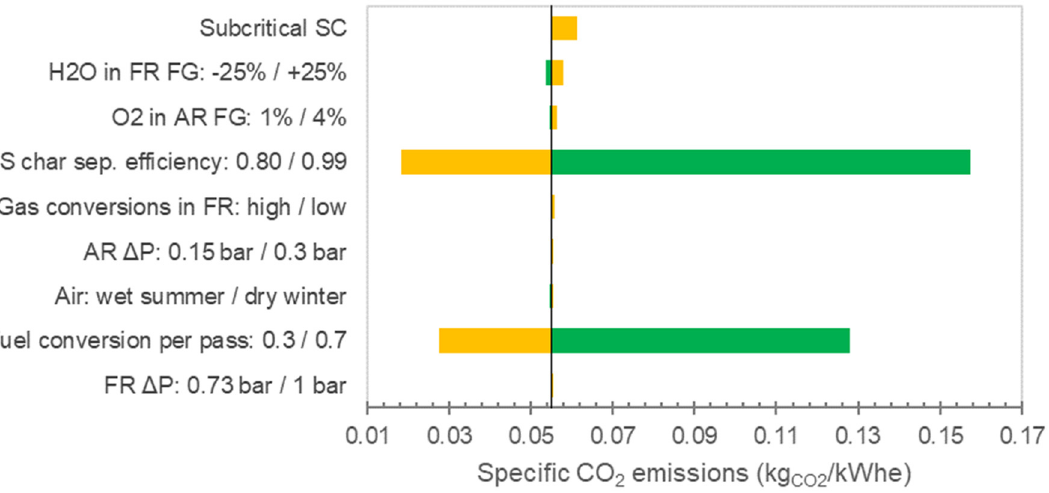
Figure 8. Variation of CLC-specific CO 2 emissions related to the different scenarios analyzed in Figure 7. As in Figure 7, the green bars correspond to the left-hand-side scenarios, while the yellow bars correspond to the right-hand-side scenarios.